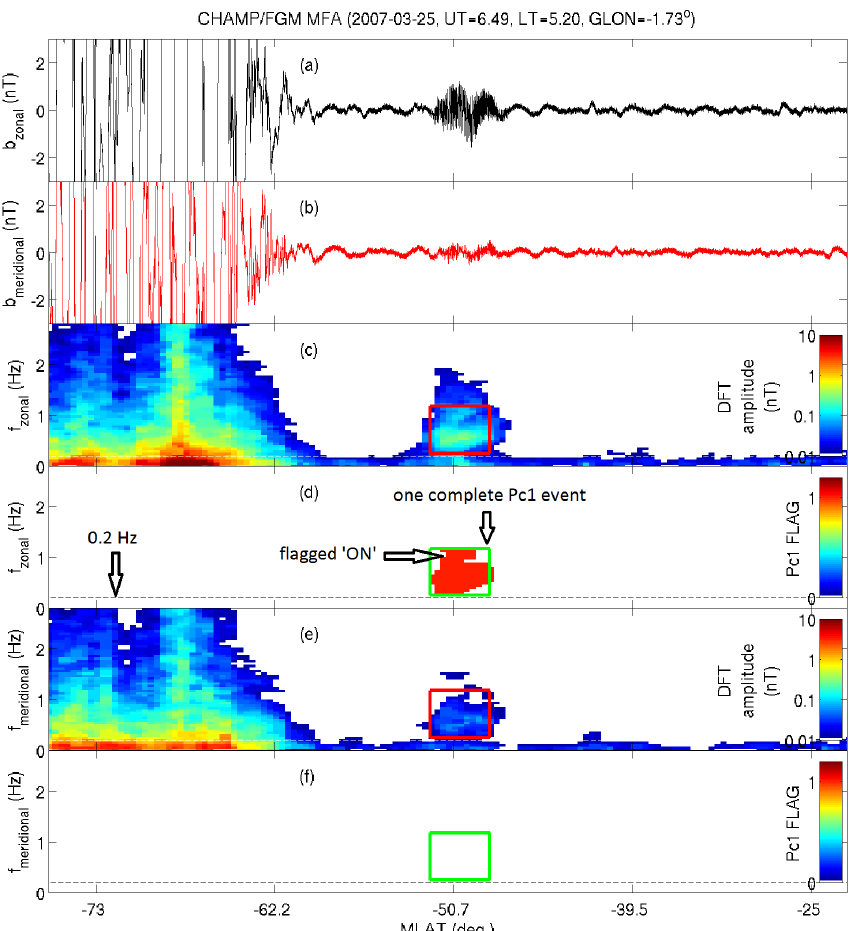
Fig. 1. An example of a Pc1 event detected automatically by our algorithm: (a) time series of 50Hz zonal B-field variation, (b) meridional B-field variation, (c) dynamic spectrum of zonal B-field, (d) Pc1 detection flag in zonal B-field (red area), (e) spectrum of meridional B-field, (f) Pc1 detection flag of meridional B-field. The rectangles in panels (c) – (f) represent the frequency vs. time range of a detected Pc1 event. The horizontal dashed line at 0.2Hz in panels (d) and (f) represents the lower frequency limit of the Pc1